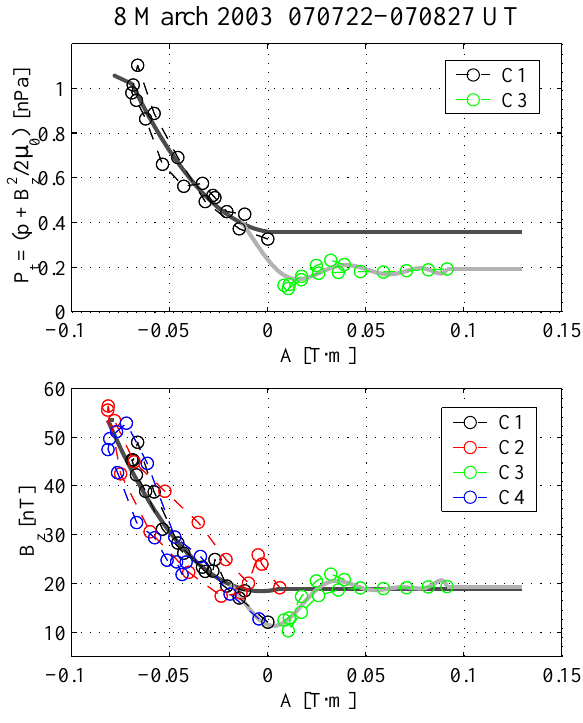
Fig. 2. Transverse pressure P t = (p + B 2 z /( 2 µ 0 )) (top) and axial magnetic field component B z (bottom) versus partial magnetic vec- tor potential A for FTE 2. The fitted curves are polynomial func- tions of A ; P t (A) is determined using the data points from C1 and C3 for which the CIS/HIA and FGM instruments were both opera- tive, while B z (A) is determined using those from all four spacecraft. The black branch of the curves is used for reconstructing the mag- netic flux rope and magnetosheath region (seen in the upper part of the maps in Fig. 3), while the gray branch is for the magnetospheric region (lower part).